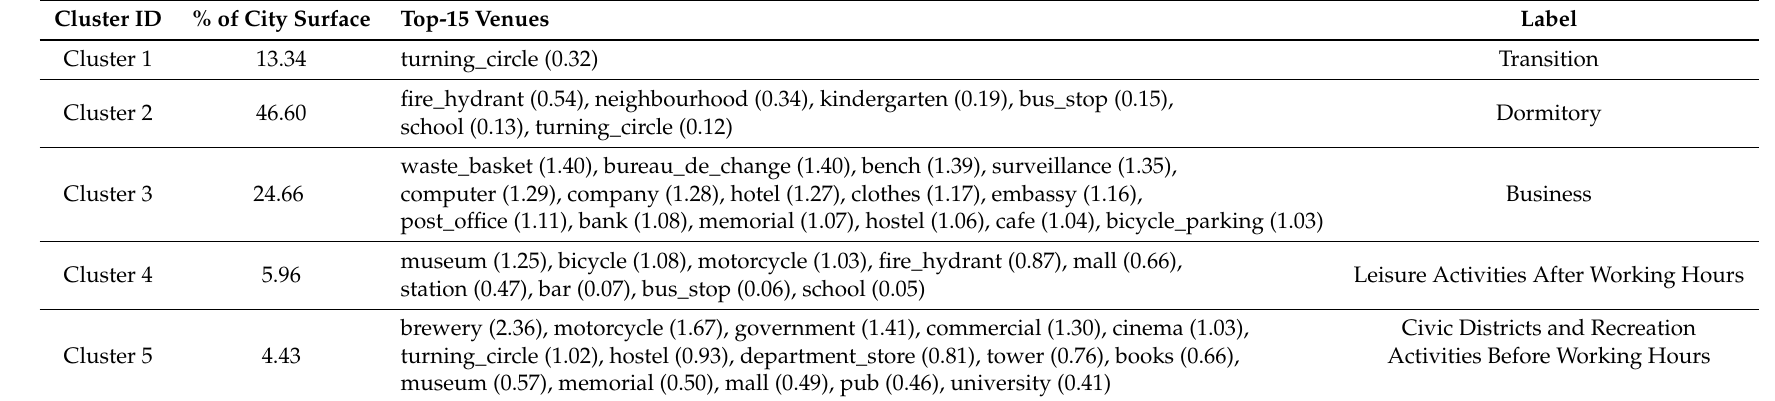
Table 1. Cluster information: assigned labels from their top-associated venues, as well as corresponding city